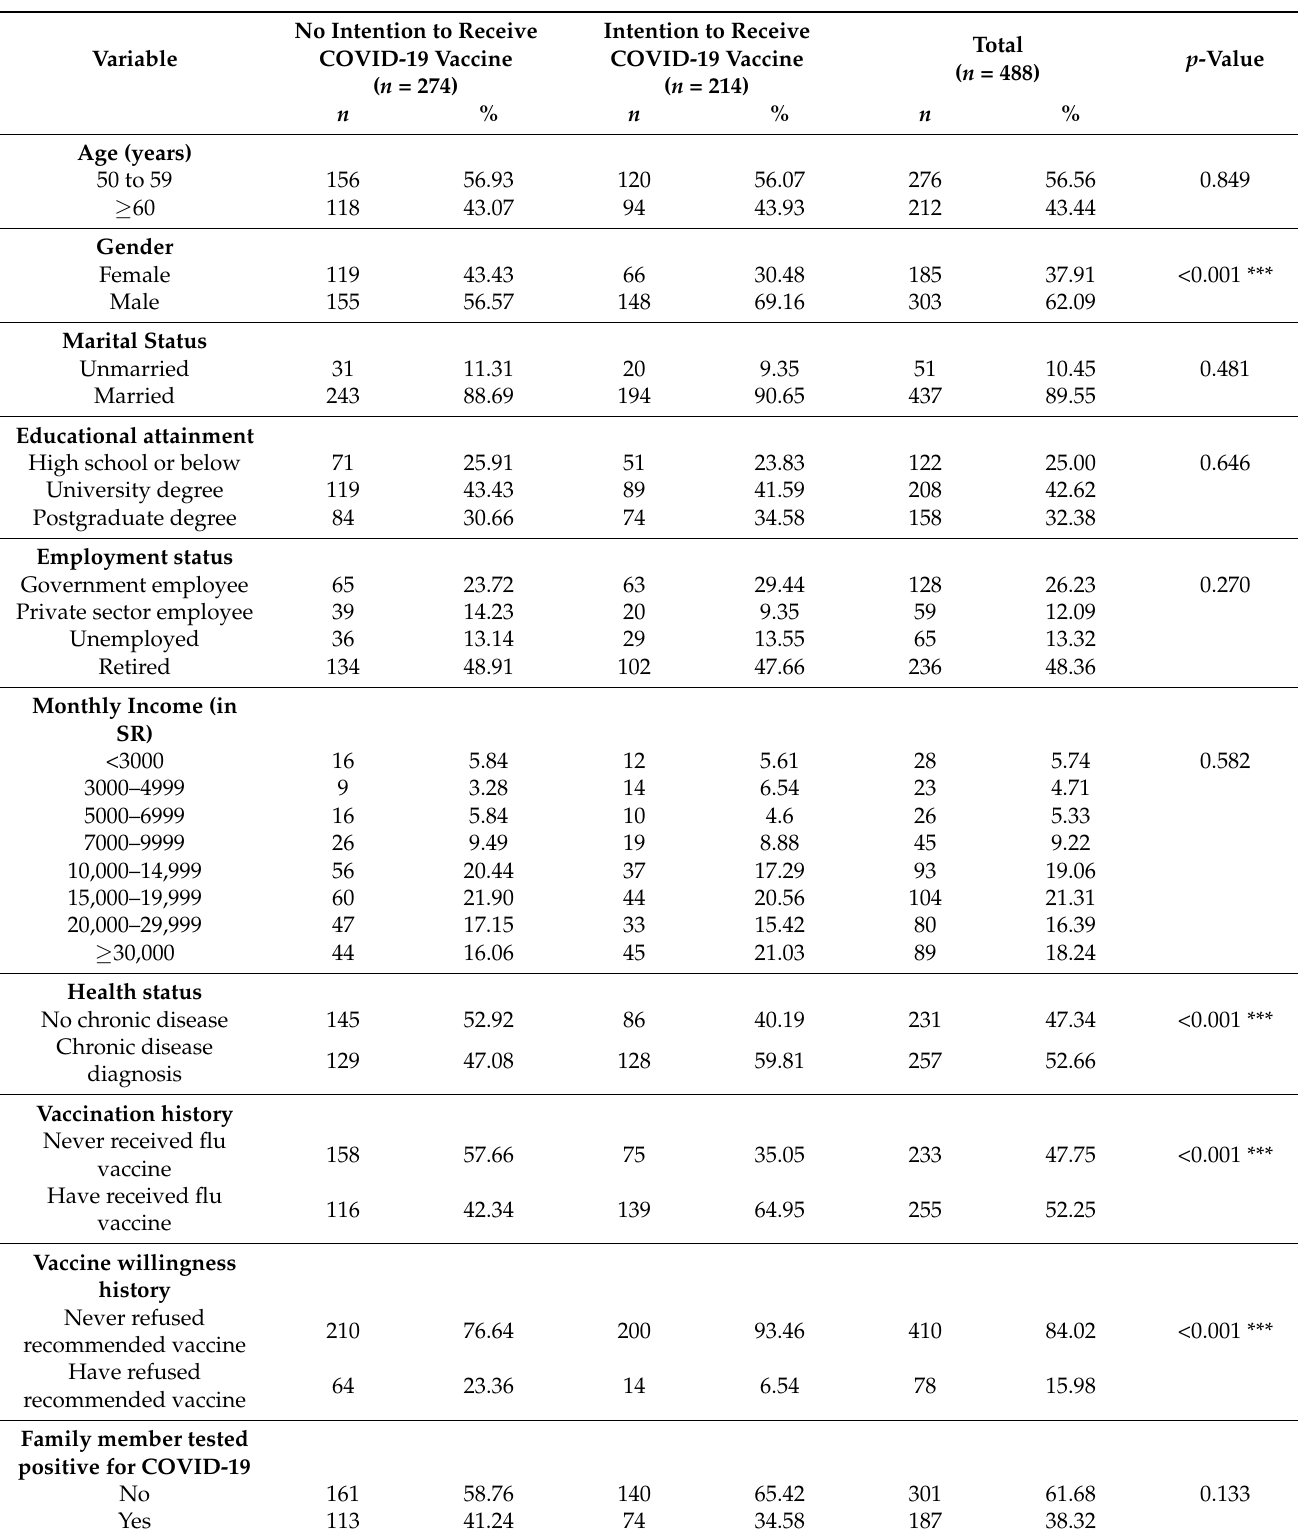
Table 1. Frequency distribution and chi-squared analysis of intentions of COVID-19 vaccination among the older adults ( n =